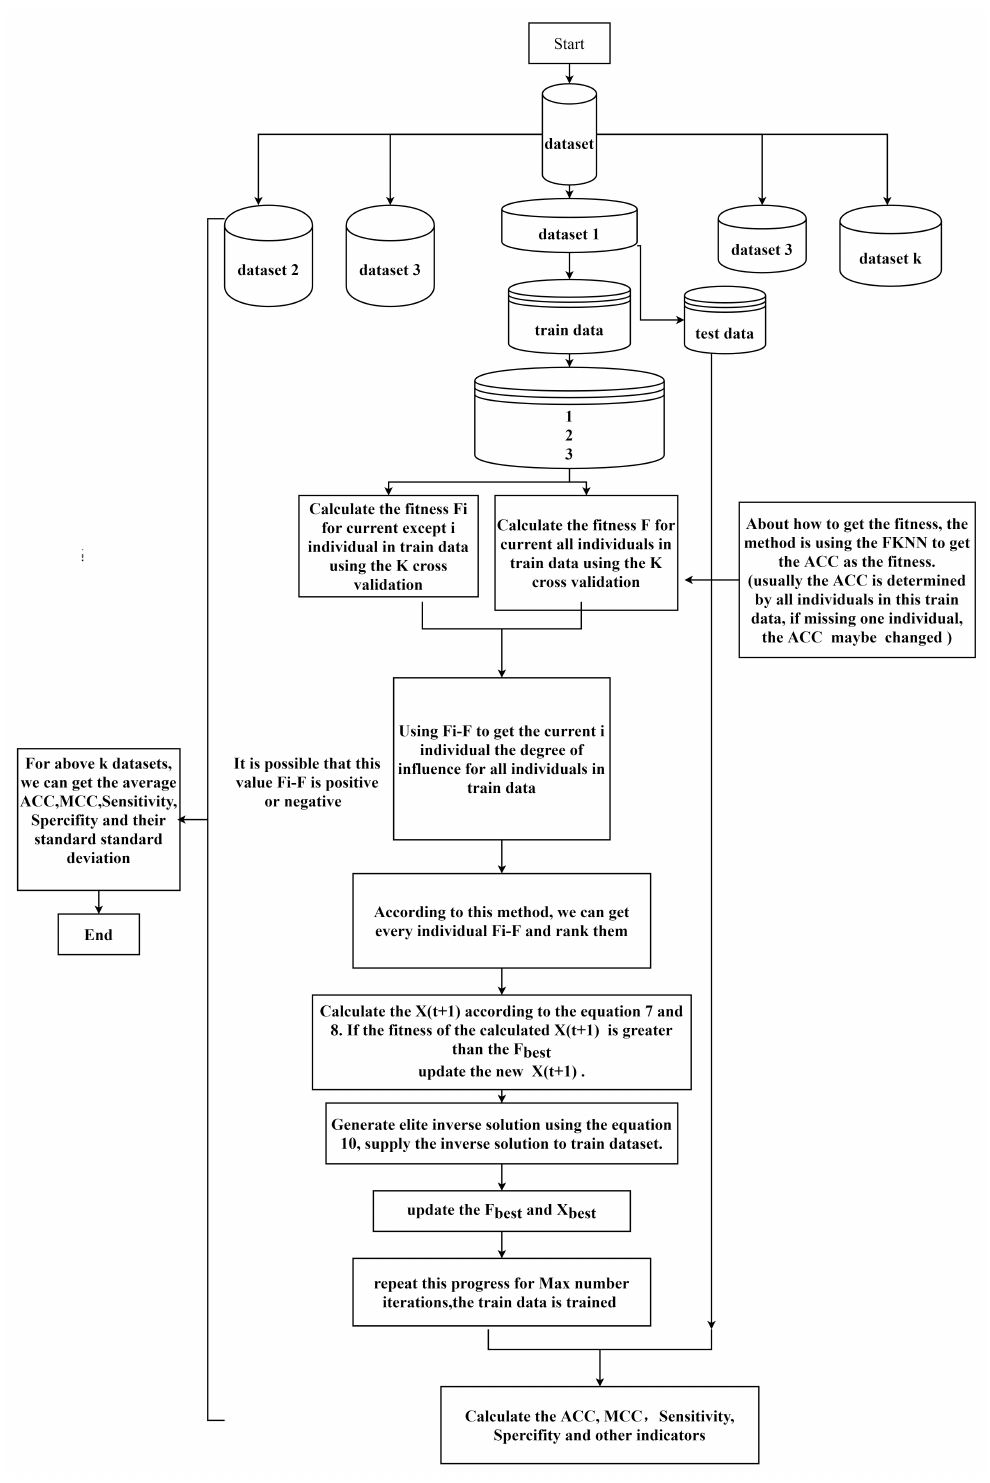
Figure 4. Numerical simulation diagram of the whole